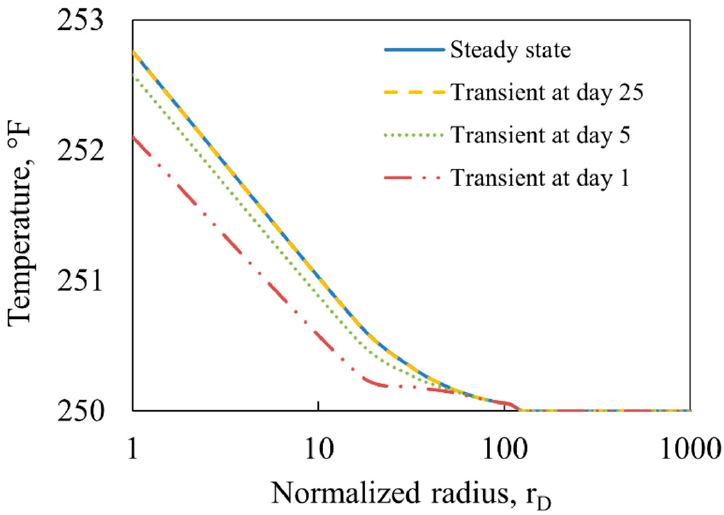
Figure 3. Transient and steady-state results with the system heat